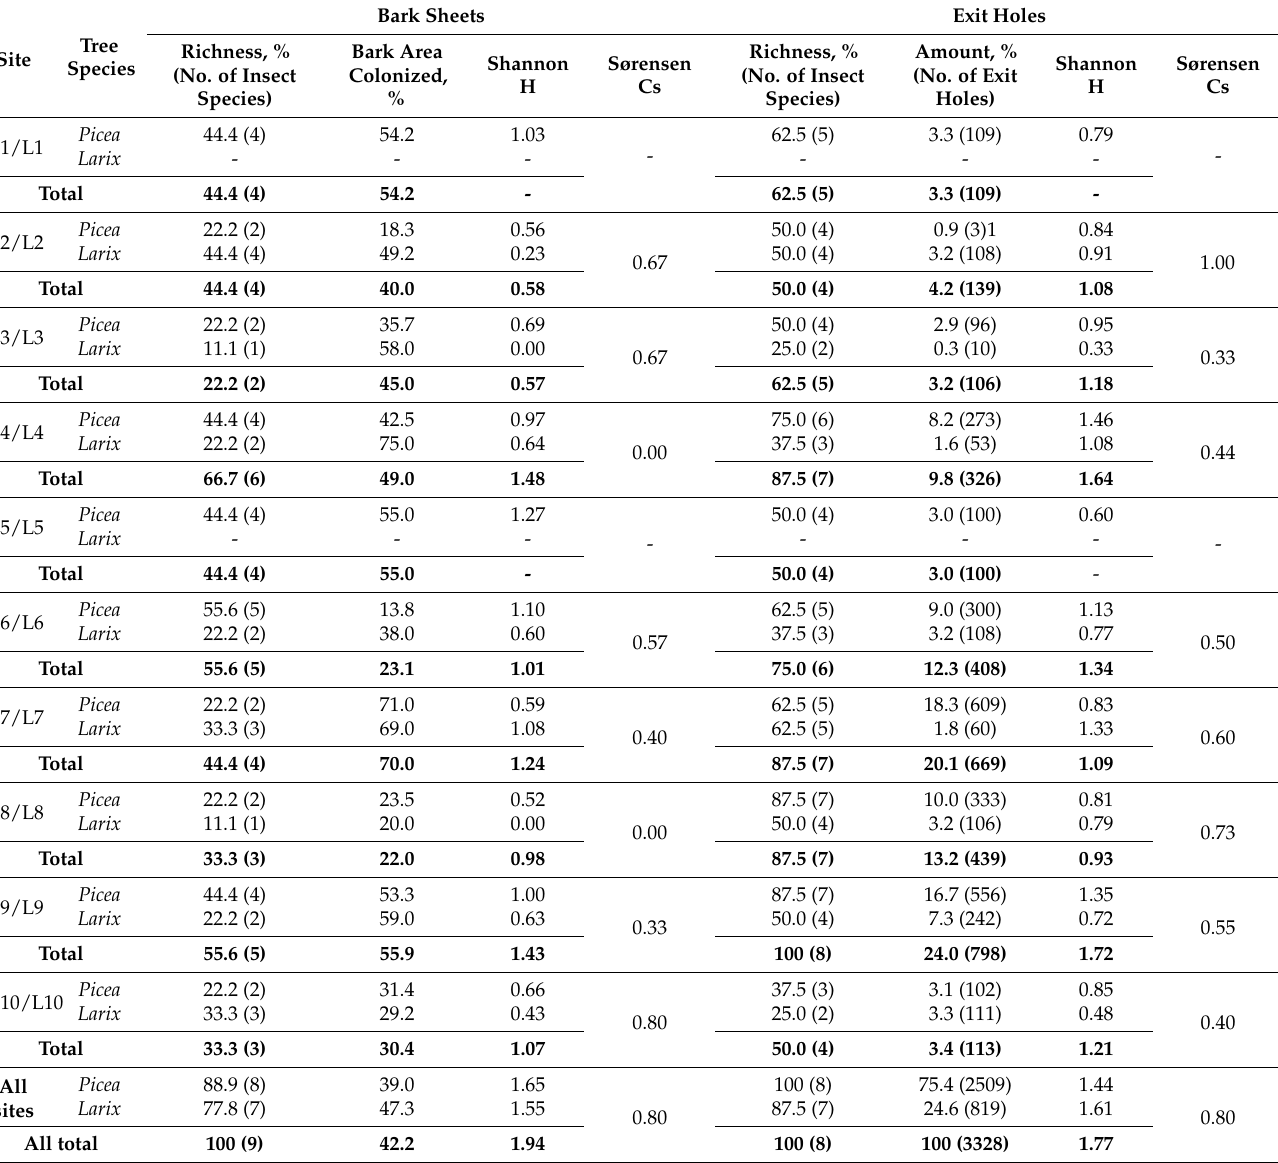
Table 4. Diversity of xylophagous insects detected using bark sheet and exit hole methods on dead Picea abies and Larix sp.